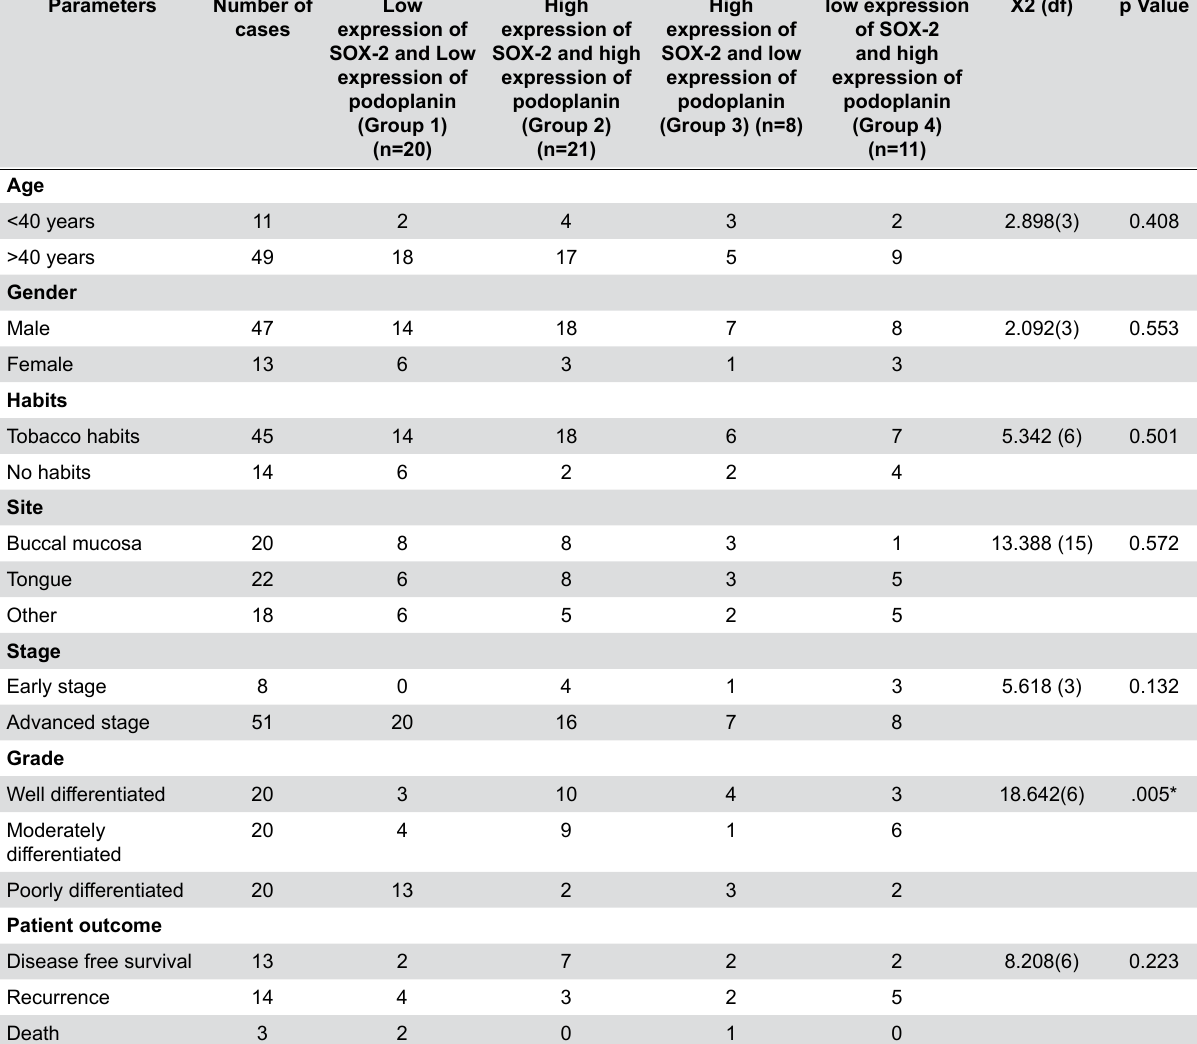
Table 2- Association of the combined expressions of SOX2 and podoplanin with clinicopathological features and patient outcomes